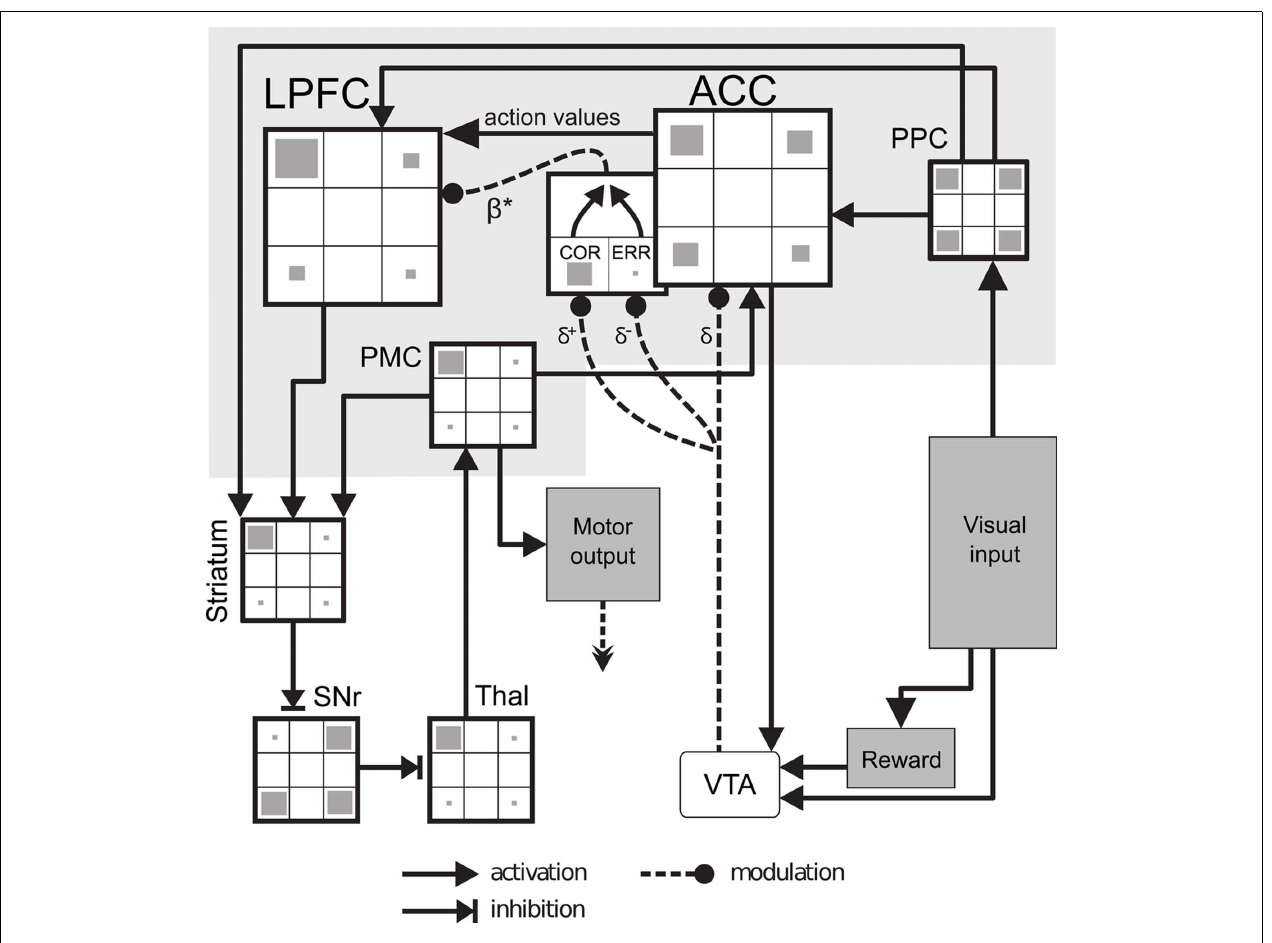
level β ∗ in ACC. Action values are sent to the lateral prefrontal cortex (LPFC) which performs action selection. A winner-take-all ensures a single action to be executed at each moment.This is performed in the cortico-basal ganglia loop consisting of striatum, substantia nigra reticulata (SNr), and thalamus (Thal) until the premotor cortex (PMC). Finally, the output of the PMC is used to command the robot and as an efferent copy of the chosen action sent to